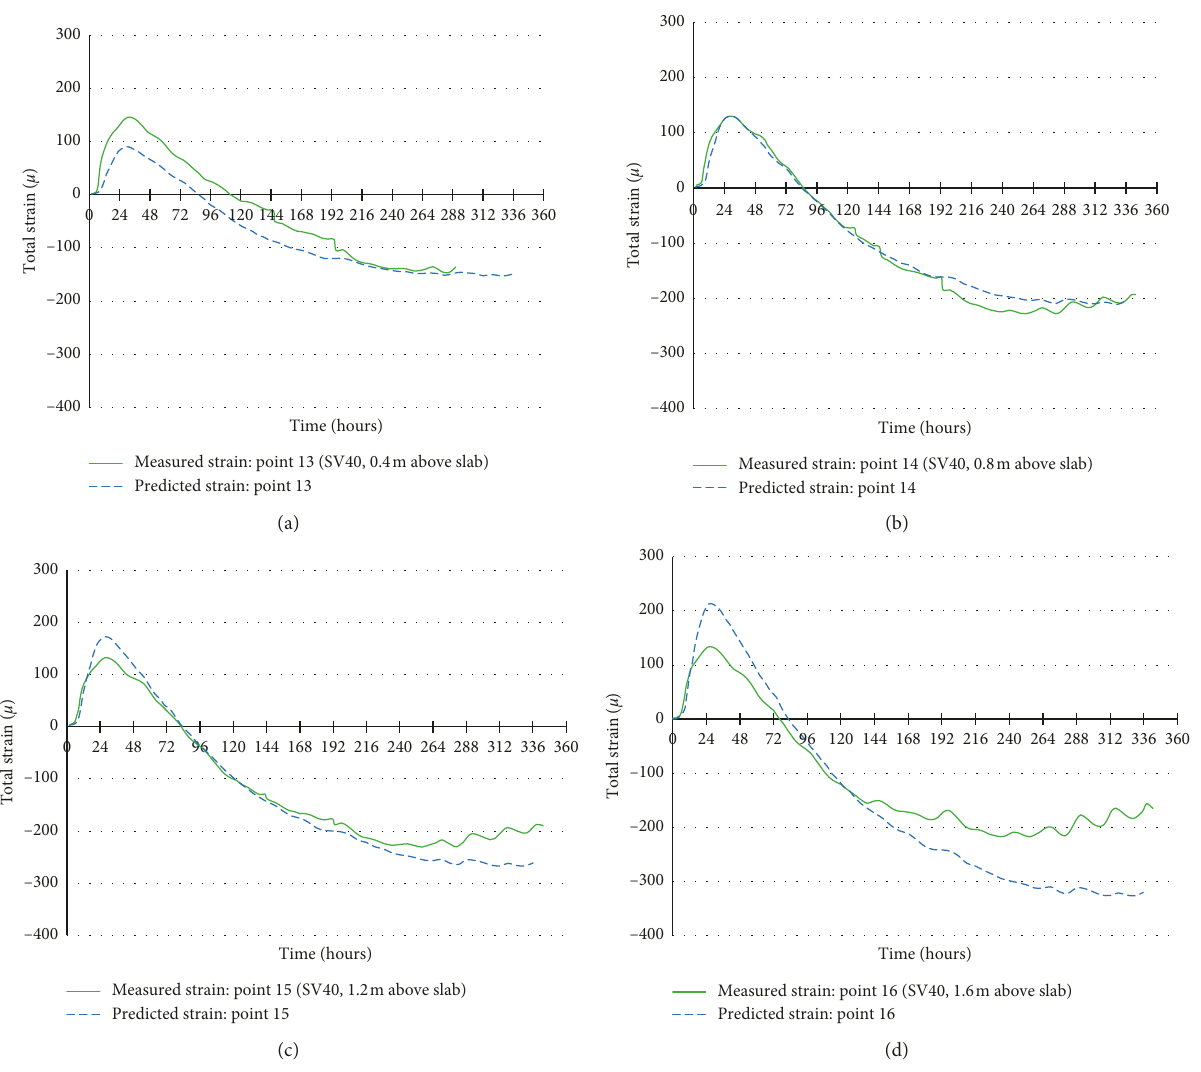
Measured strain: point 15 (SV40, 1.2m above slab) Predicted strain: point 15